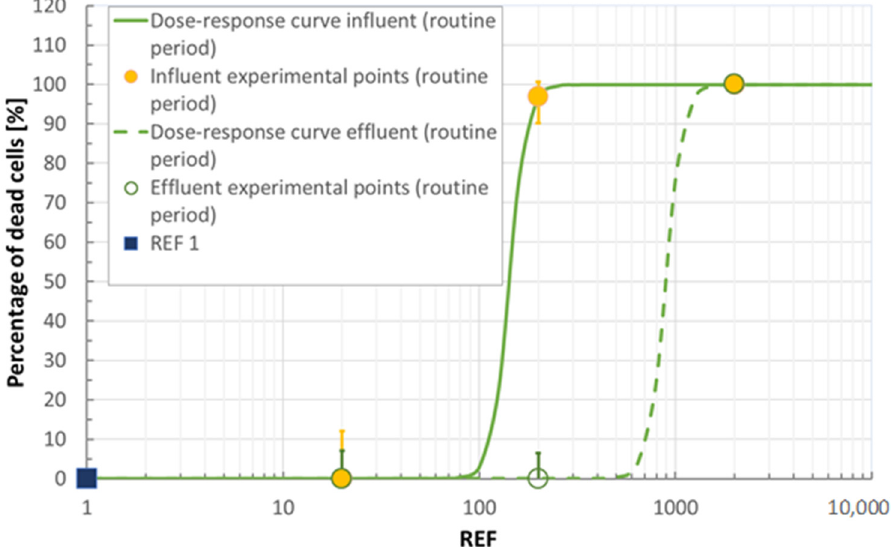
Figure 6. Cell viability in IAR203 hepatic cells exposed to different concentrations of influent and effluent wastewaters (second campaign). Values are expressed as % versus the untreated control. Cell viability was assessed with Neutral Red Assay in triplicate: error bars show maximum and minimum values.